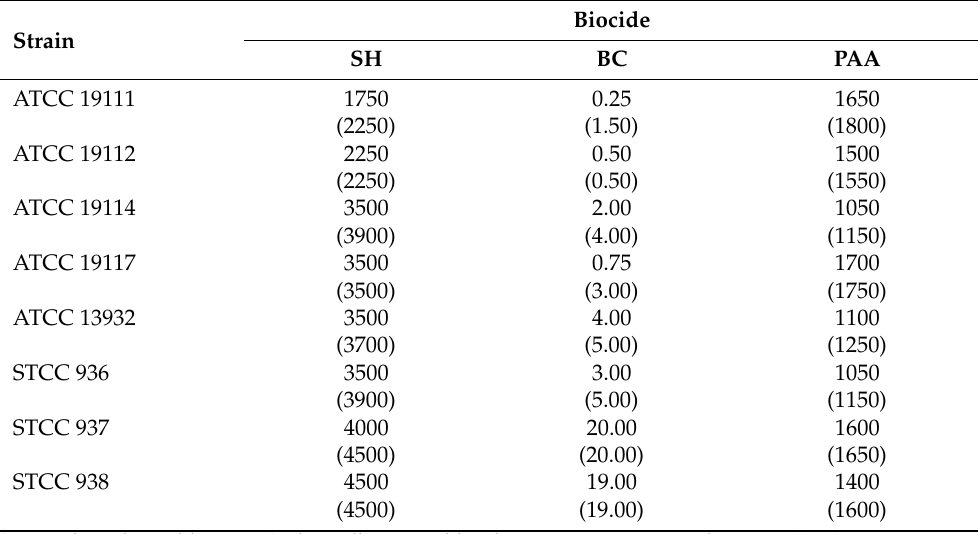
Table 2. Minimum inhibitory concentration (MIC; ppm) and minimum bactericidal concentration (MBC; ppm) for three biocides on eight strains of Listeria monocytogenes .